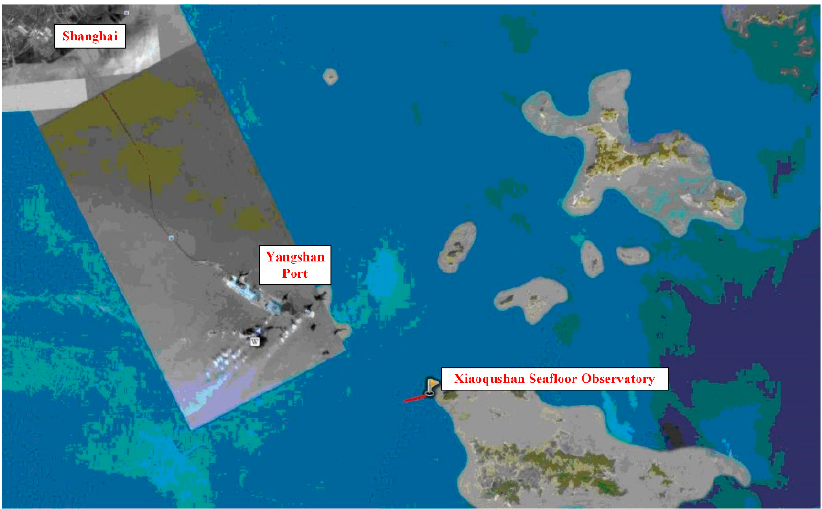
Figure 7. Location of the Xiaoqushan Seafloor Observatory.